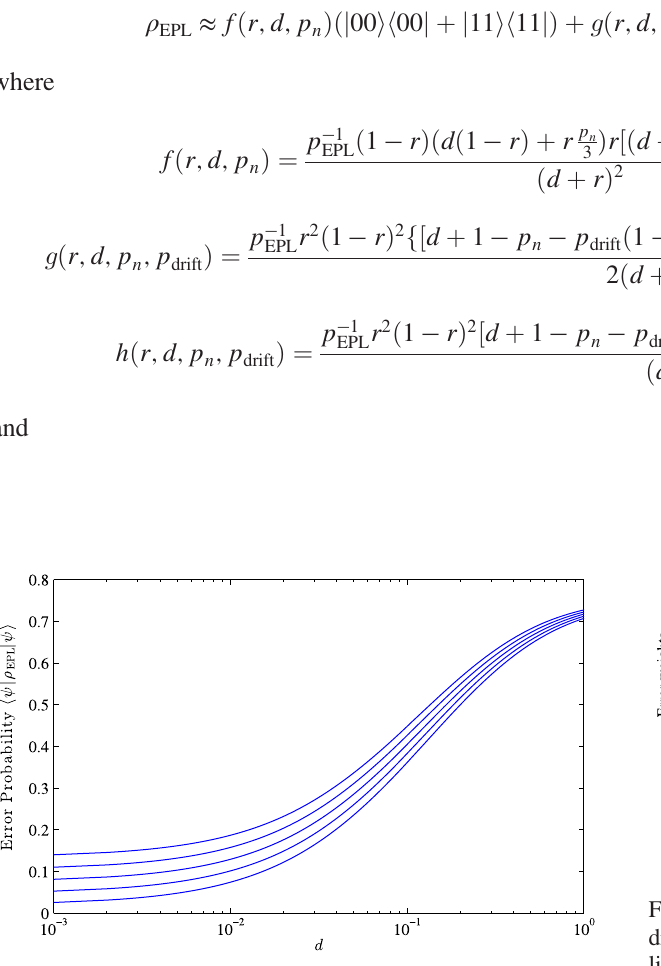
FIG. 13. Total error probability. Here, we take r ¼ 1 0 . 01 . The five lines represent the total error probability p drift ¼ corresponding, from bottom to top, to preparation error proba- 0 ; 0 . 025 ; 0 . 05 ; 0 . 075 ; 0 . 1 g . The error probability bilities p n ¼ f is close to the error rate without dark counts while d is below approximately 0.01 but increases rapidly thereafter, passing through the distillation threshold even for the case p